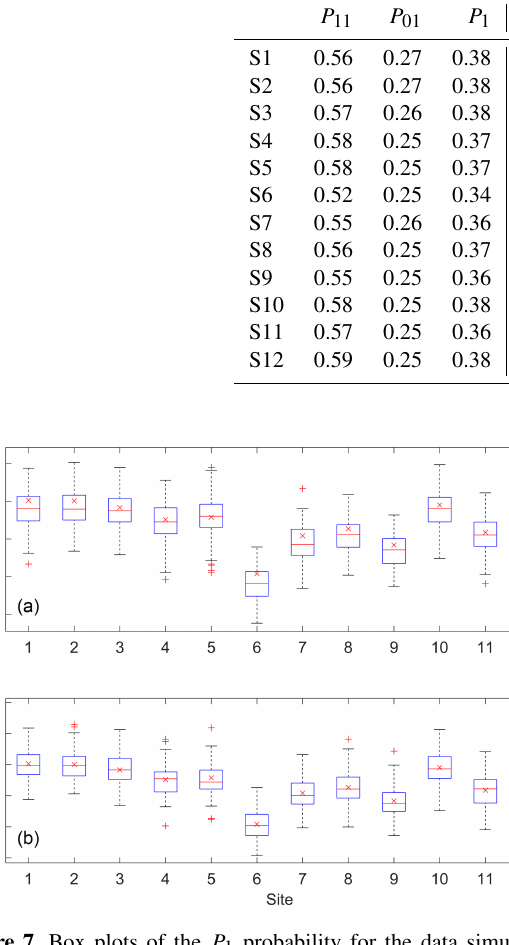
Figure 7. Box plots of the P 1 probability for the data simulated from the DKNNR model (a) and the MONR model (b) , as well as the observed ( x marker) for the 12 selected weather stations from the Yeongnam